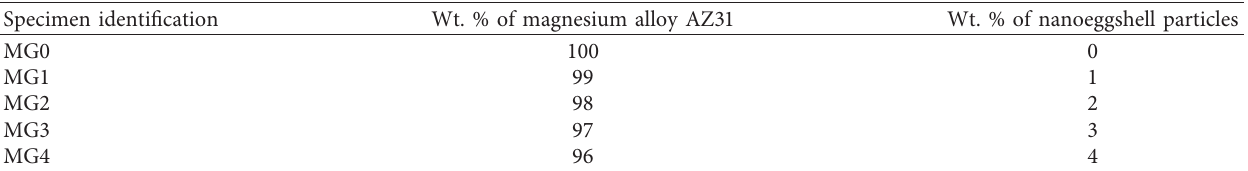
Table 2: Composition details of the composite specimens.